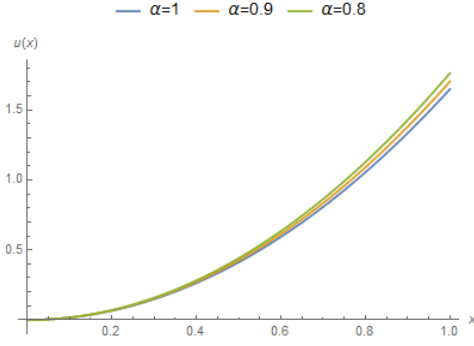
Figure4: Absolute error of example1 at Figure 4. Absolute error of Example 1 at α = 1. (cid:11) = 1